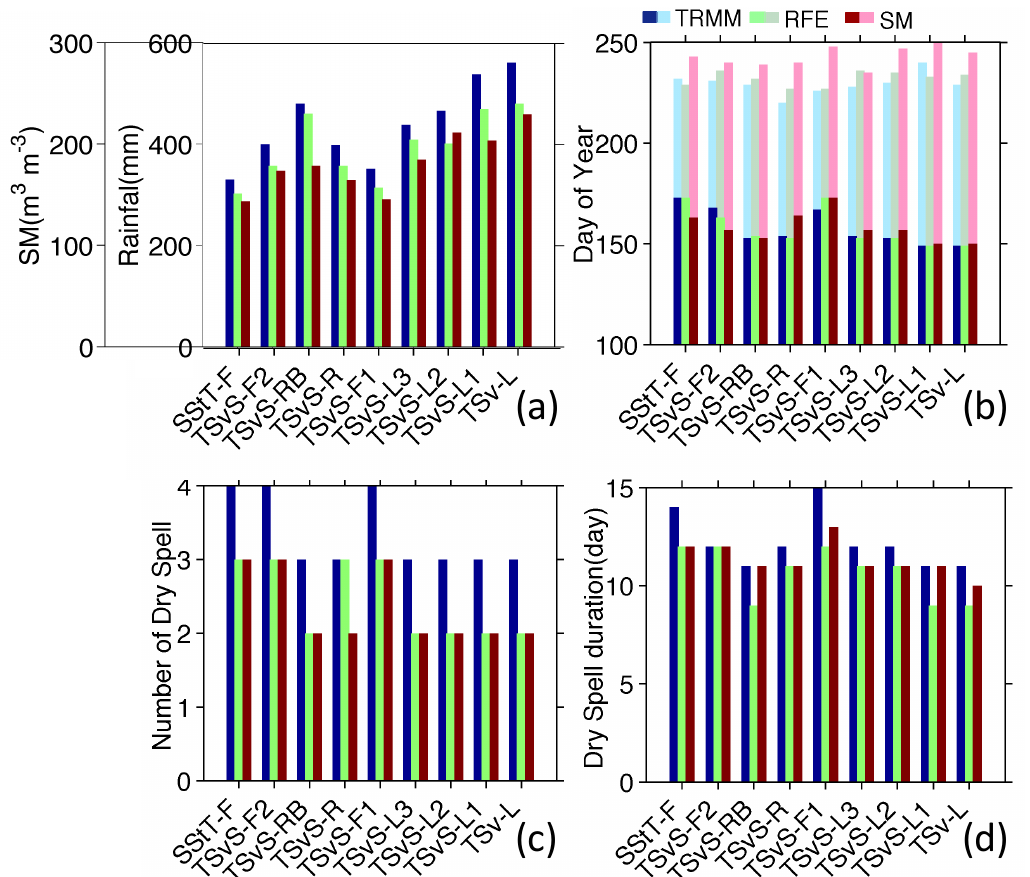
Figure 6. Comparison between some parameters characterizing the rainy season from TRMM3B42, RFE 2.0 and soil moisture (SM) in average on each vegetation soil zone (VSZ, see Table 3 for legend items) over the 2000–2010 decade: ( a ) cumulative rainfall and SM; ( b ) dates of onset and maximum (respectively in dark and clear colors); ( c ) number of dry spells and ( d ) the longest dry